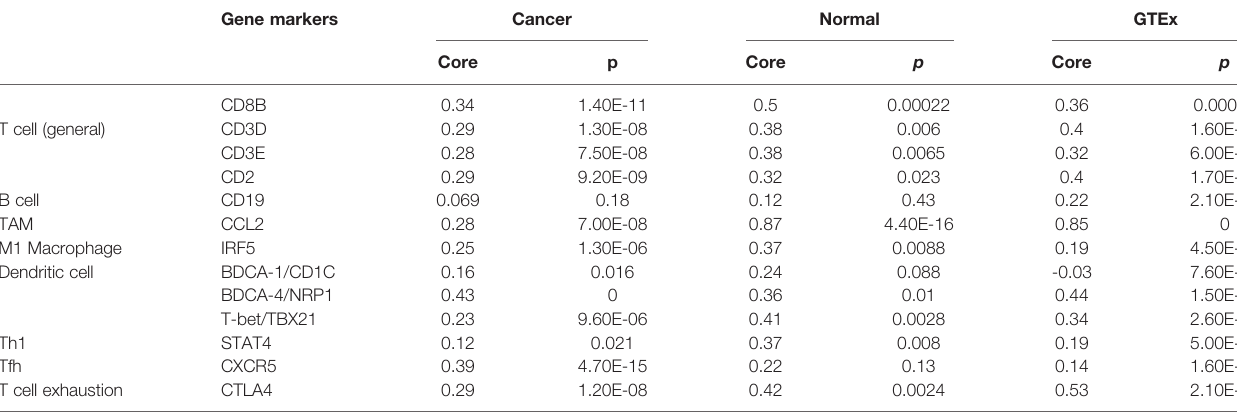
TABLE 4 | Correlation analysis between CCL14 and marker genes of immune cells in GEPIA. Gene markers Cancer